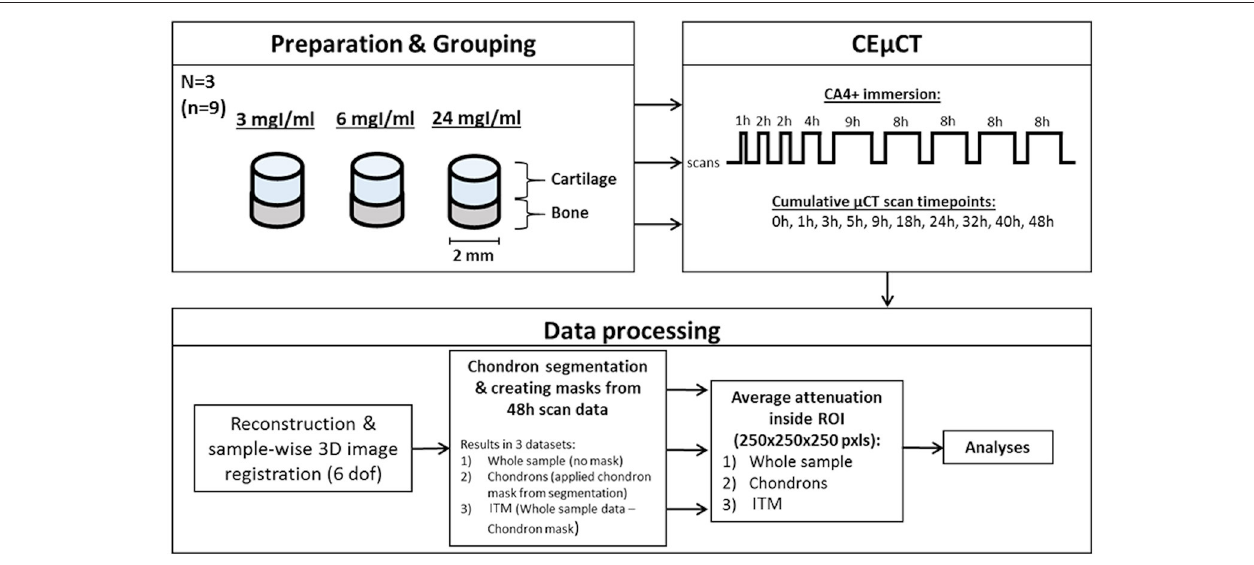
FIGURE 1 | Flow chart of the sample procedure for diffusion sample set. Three adjacent cylindrical (diameter = 2 mm) osteochondral samples ( n = 9) were harvested from three human femurs and divided to groups depending on the concentration of CA4 + immersion bath. Samples were scanned prior the immersion and in several timepoints (0–48h) during the CA4 + immersion. Data-processing included reconstruction of µ CT datasets, co-registration, segmentation of chondrons, and selection of Volume of Interests (VOIs) prior the analysis.